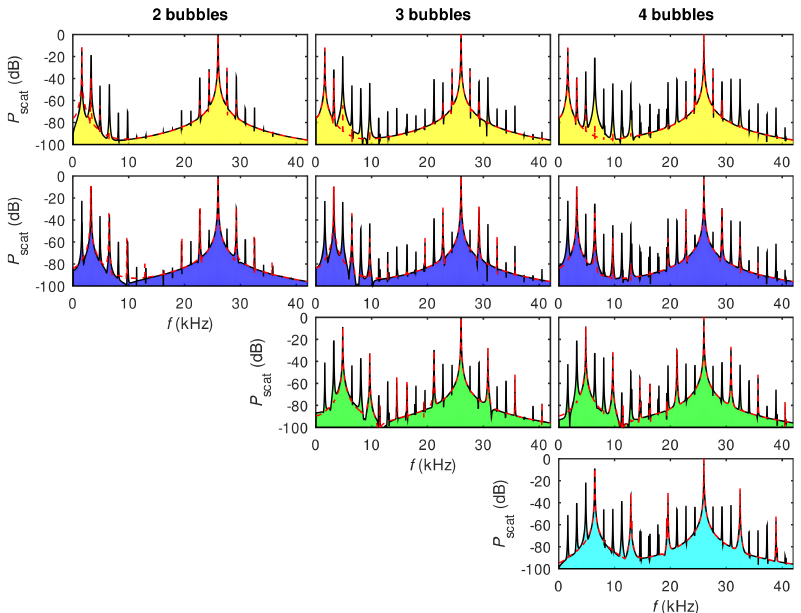
Figure 16. Columns (from left to right) show the AFC spectra produced by individual bubbles within clusters consisting of two, three and four bubbles with the equilibrium radii R n 0 = 1.95/ n mm, where n is the bubble index in the cluster. The number of panels in each column corresponds to the total number of bubbles. The red dashed lines in each panel show the spectra of individual non-interacting stationary bubbles with identical equilibrium radii. Computational parameters are given in [22]. Reproduced from [22]. Copyright 2021 by the American Physical